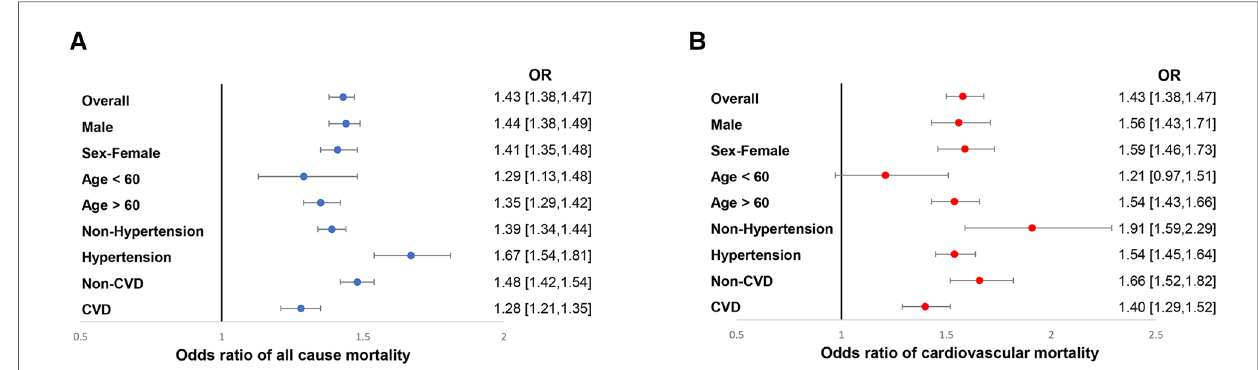
FIGURE 3 Subgroup analysis of the association between ePWV with all-cause ( A ) and cardiovascular mortality ( B ) among participants with diabetes. HRs were adjusted for sex, race/ethnicity, study circles, education levels, smoking, drinking, hypertension, and CCI. ePWV, estimated pulse wave velocity; CCI, Charlson comorbidity index.